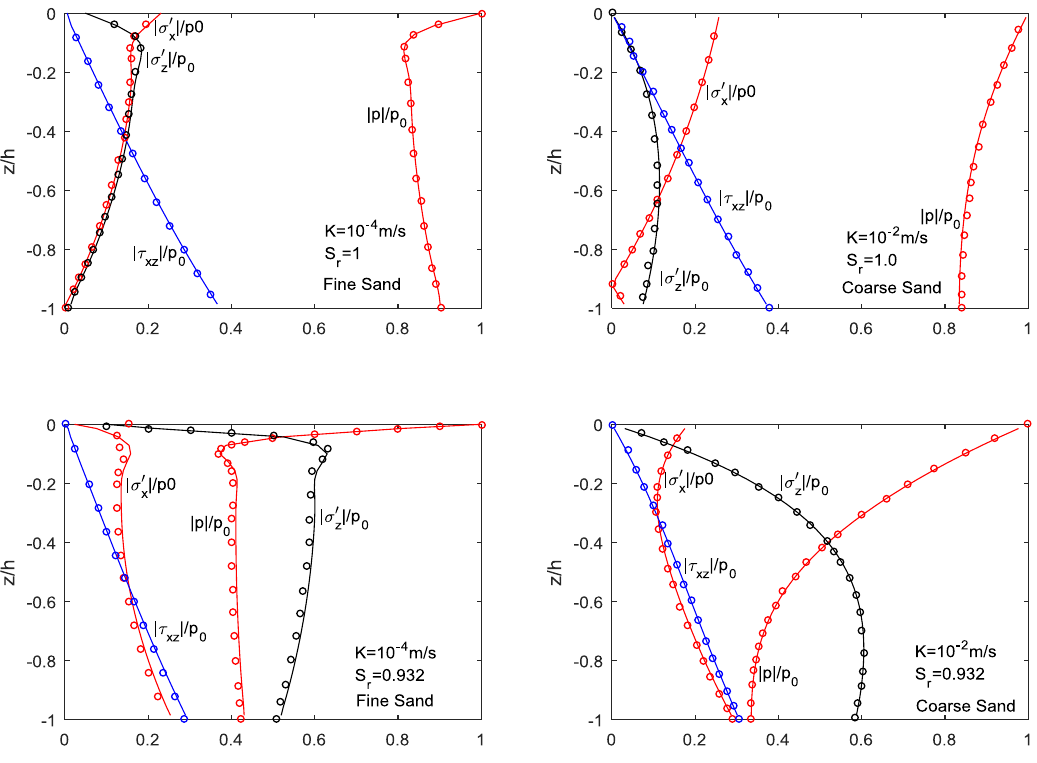
Figure 4. Comparison of the vertical distribution of pore pressure ( | p | / p 0 ) and stresses ( | σ (cid:48) x | / p 0 , | σ (cid:48) | / p | τ xz | / p 0 and 0 ) versus z / h between the present model (the solid lines) and analytical z solutions [38]